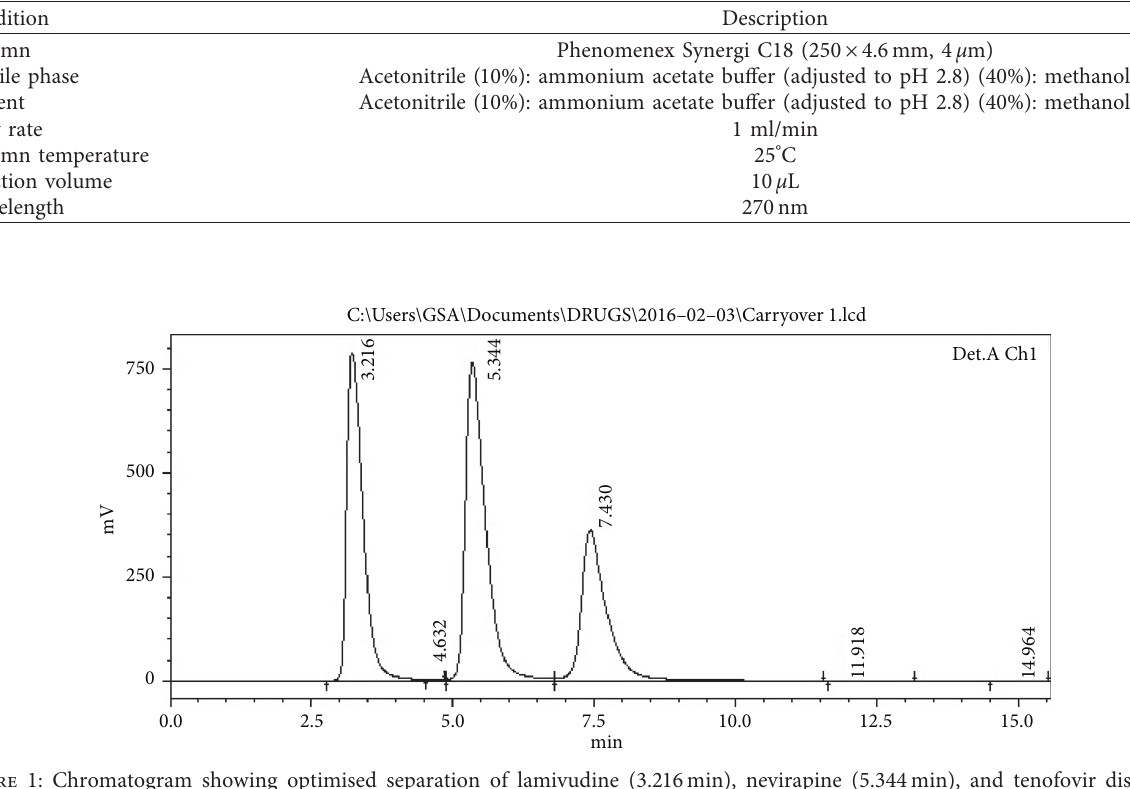
Table 3: Optimised chromatographic conditions adopted for the validation.